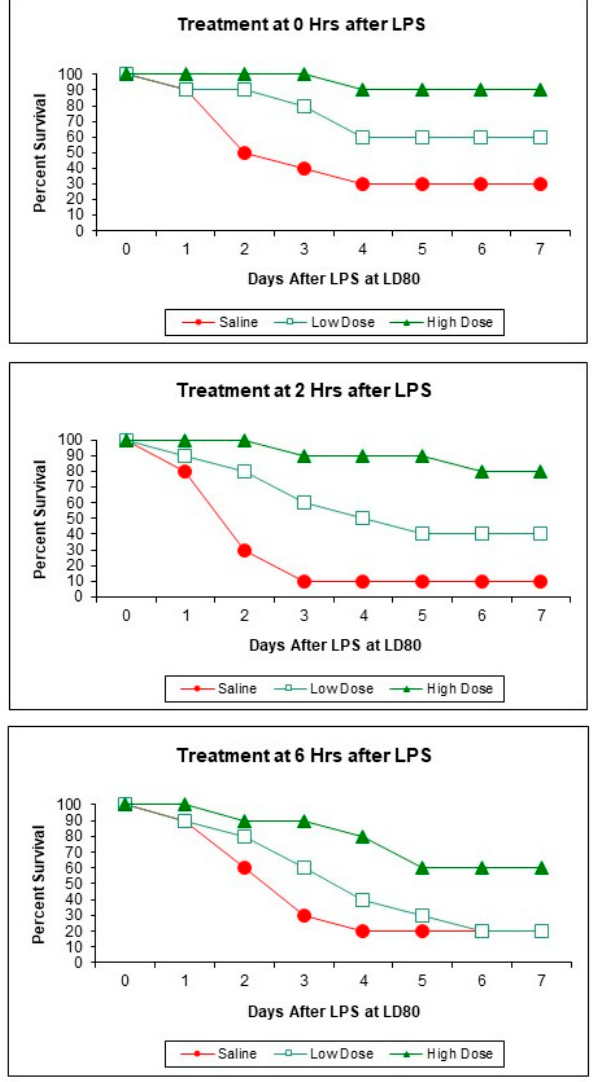
Figure 2. These Kaplan–Meier survival curves demonstrate intervention with both the low dose (125 ng/gm body weight) and the high dose (1.25 µg/gm body weight) of rHJ mAb was effective at rescuing the mice from death by sepsis as compared with the saline control group. The earlier rHJ mAb was administered and the higher the dose given, the more effective it was. Similar results were also obtained when an LD 80 dose of TNF α or an LD 80 dose of MV-A iNOS was given IV as the challenge.